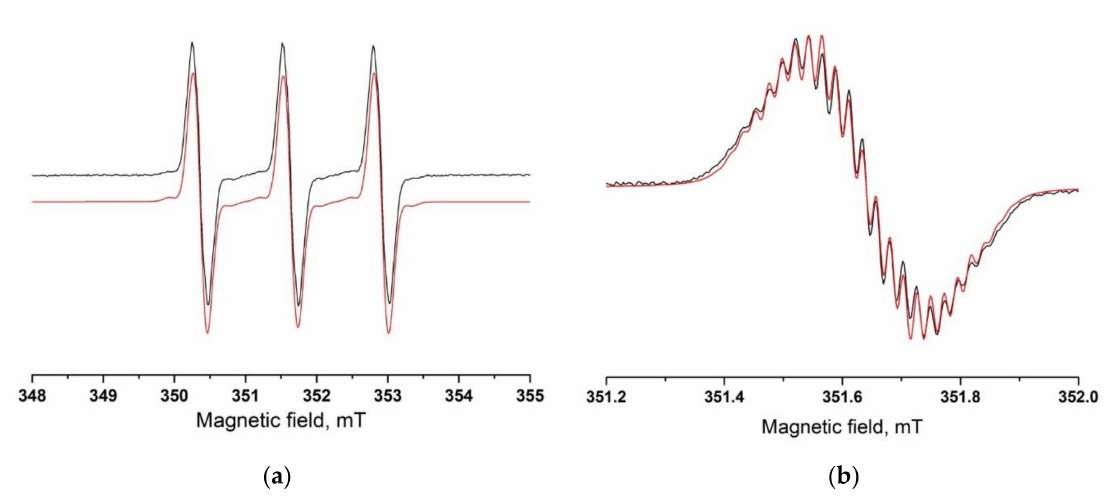
Figure 3. Experimental (black curves) and simulated (red curves) ESR spectra of 5; ( a ) the whole spectrum; ( b ) the central